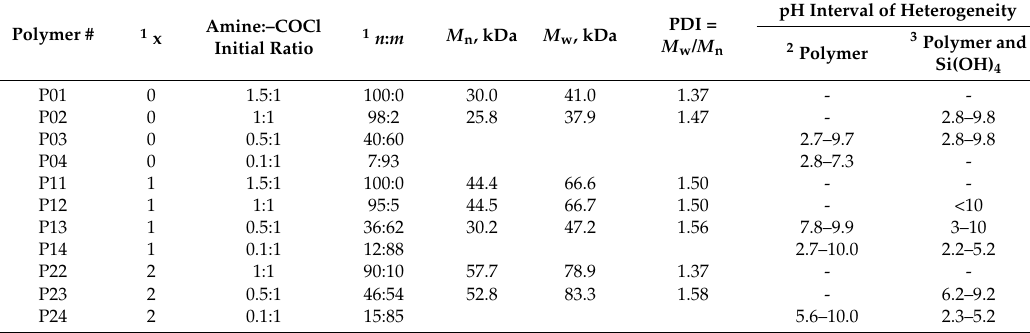
Table 1. Composition of the reaction mixture and polymers obtained by PAC reaction with polyamines.